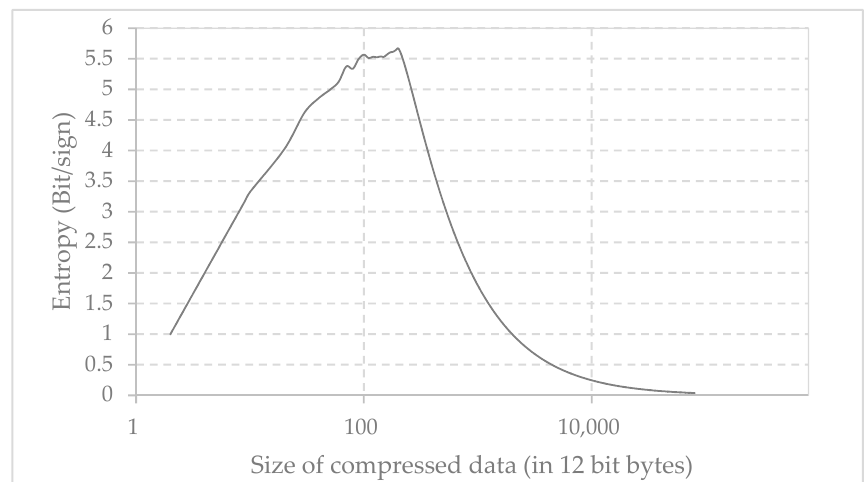
Figure 10. The e ff ect of block size on compression e ffi ciency. Figure 10. The effect of block size on compression efficiency.